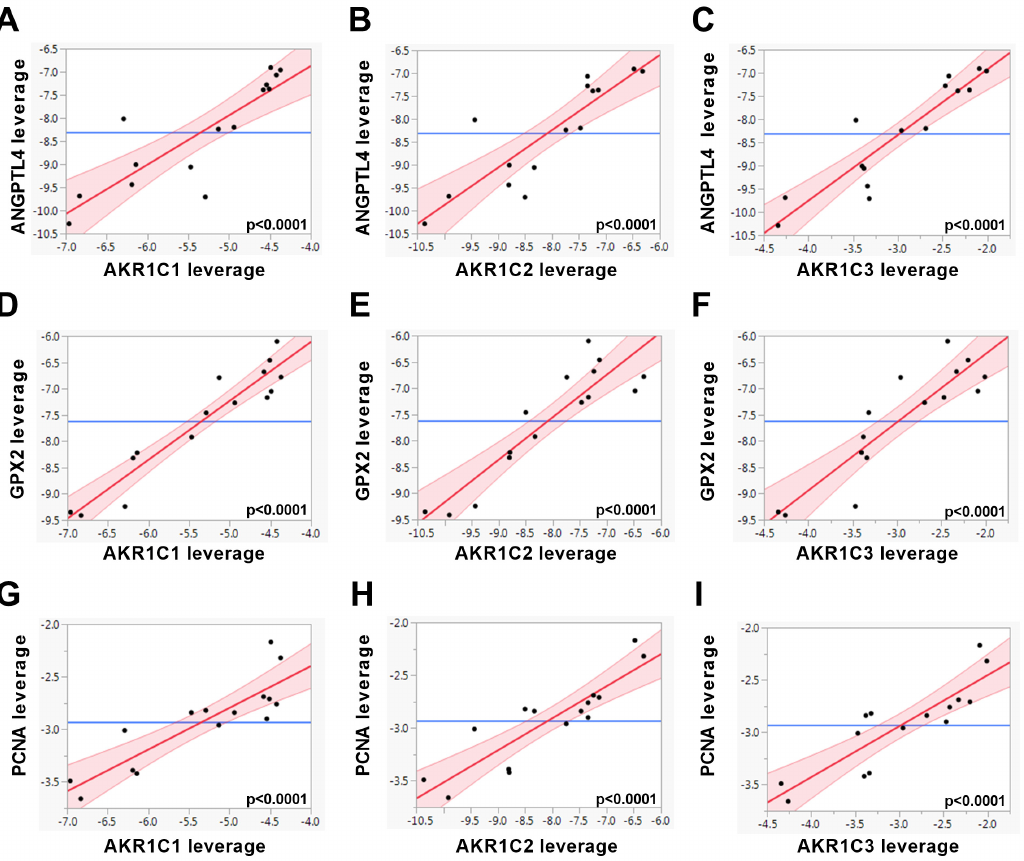
Figure 4. The gene expression levels of AKR1C1, AKR1C2, and AKR1C3 were associated with the genes indicated using multiple linear regression models in 5.5, 11.25, and 17.5 mM glucose-treated PC3 cells ( n = 15) and are shown as leverage plots. Statistical significance was considered as p < 0.05. The p -values are indicated in the figure.